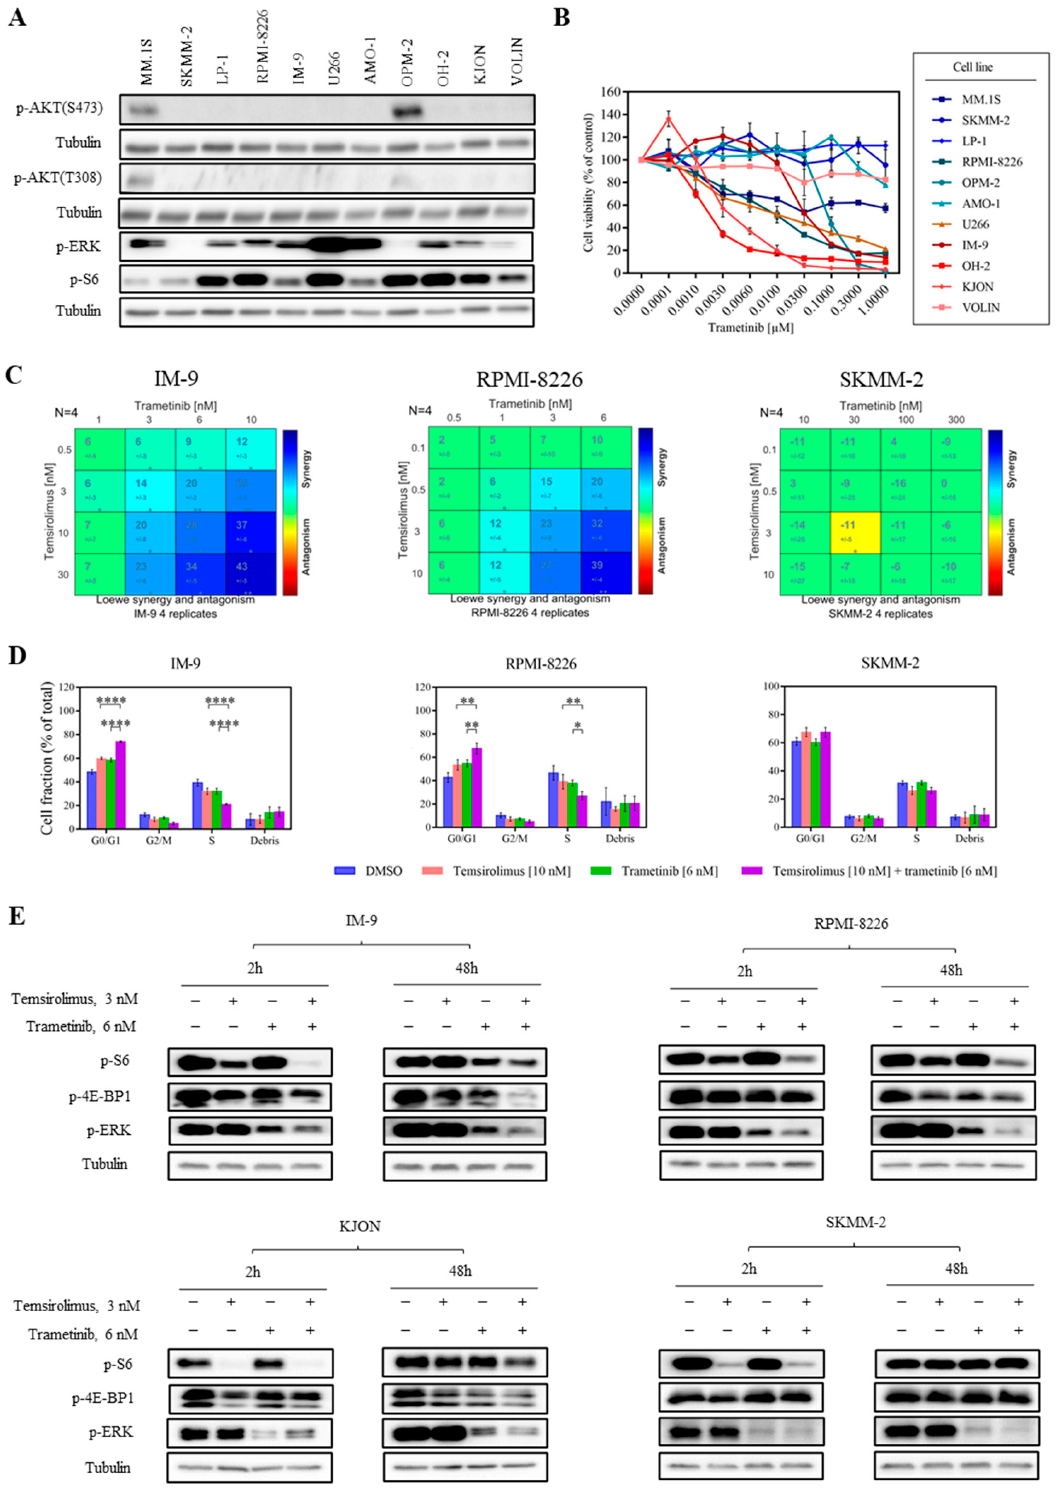
Figure 3. Temsirolimus and trametinib act synergistically in MM cell lines. ( A ) Basal levels of AKT (S473 and T308), ERK, and S6 phosphorylation in MM cell lines were detected by Western blotting using specific antibodies. Tubulin was the loading control. Representative results from at least three independent experiments are shown. ( B ) MM cell lines were incubated for 5 days with MEK inhib- itor trametinib. Viable cells were determined. Representative results from at least three independent experiments is shown. Error bars indicate standard deviations. ( C ) Synergy score matrix for temsiro- limus and trametinib combination treatment of MM cell lines. Combinatorial treatment induced synergistic cytotoxicity in IM-9 and RPMI-8226 cell lines. In contrast, the SKMM-2 cell line was af- fected by neither single nor combined inhibitor treatments. ( D ) Cell cycle following treatment with either vehicle control, temsirolimus alone, trametinib alone, or with both temsirolimus and